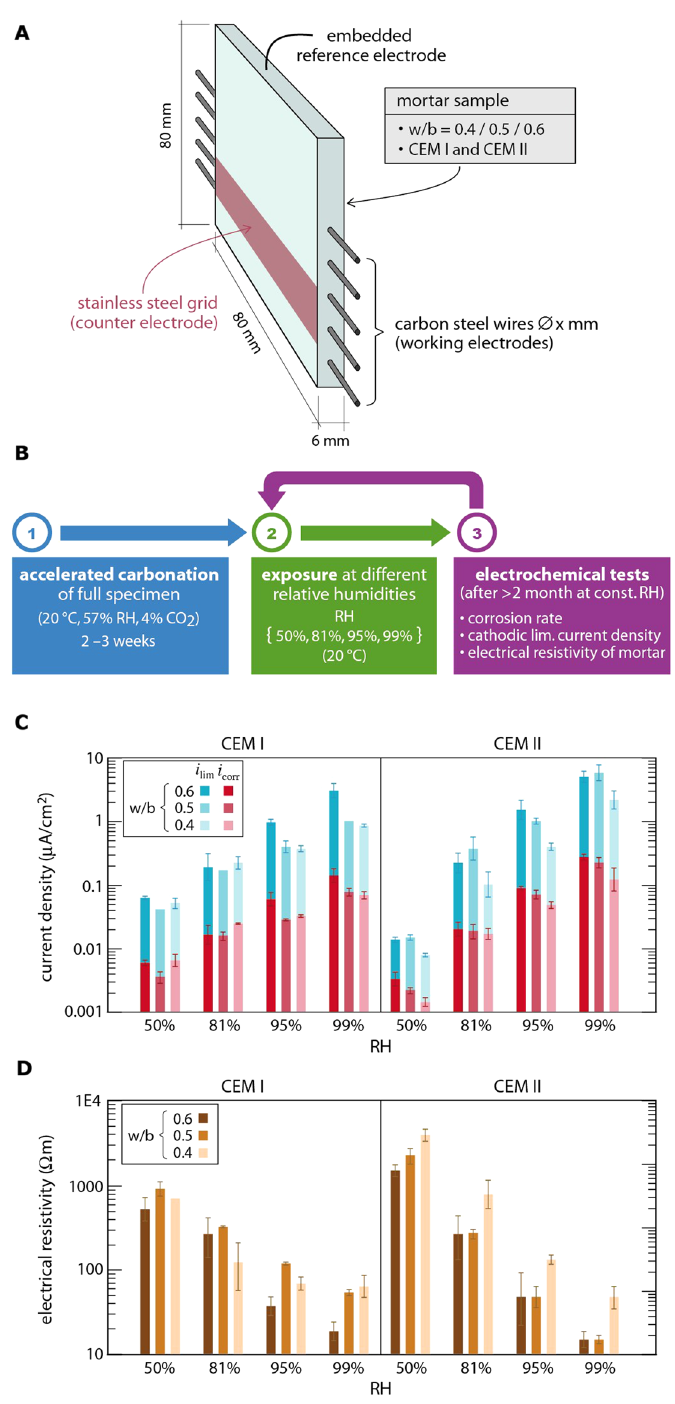
Figure 1. Effect of relative humidity (RH) on corrosion rate and other electrochemical parameters in carbonated mortar. ( A ) Sample geometry and instrumentation with embedded steel wires and sensors (Supplementary Figures 1 and 2); (B) Experimental procedure including initial carbonation followed by exposure at different RH and corresponding electrochemical measurements; (C) Cathodic limiting current density ( i lim ) and corrosion rate ( i corr ) for the different studied systems (water/binder ratios and cement types) as a function of RH (Supplementary Table 1); (D) Electrical mortar resistivity as a function of material parameters and RH (Supplementary Table